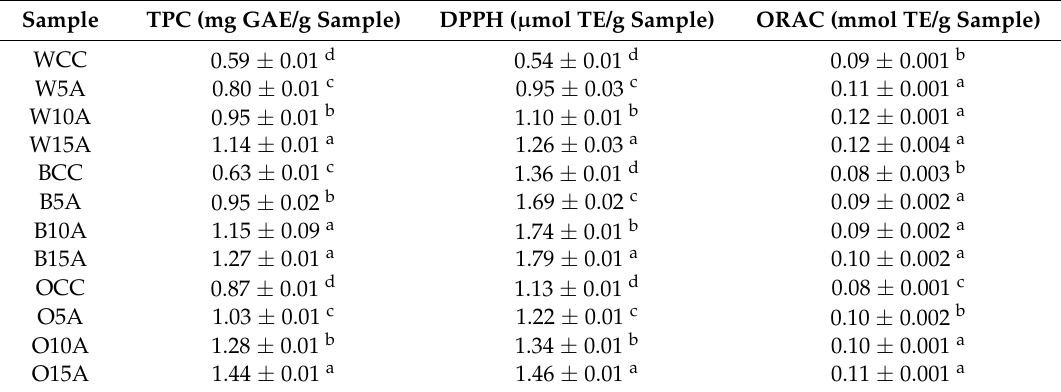
Table 4. Total phenolic content and antioxidant